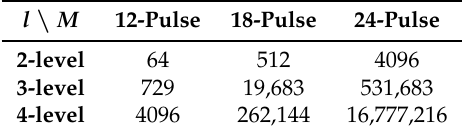
Table 1. Number of space vectors for M -pulse modular VSI with l -level modules. l \